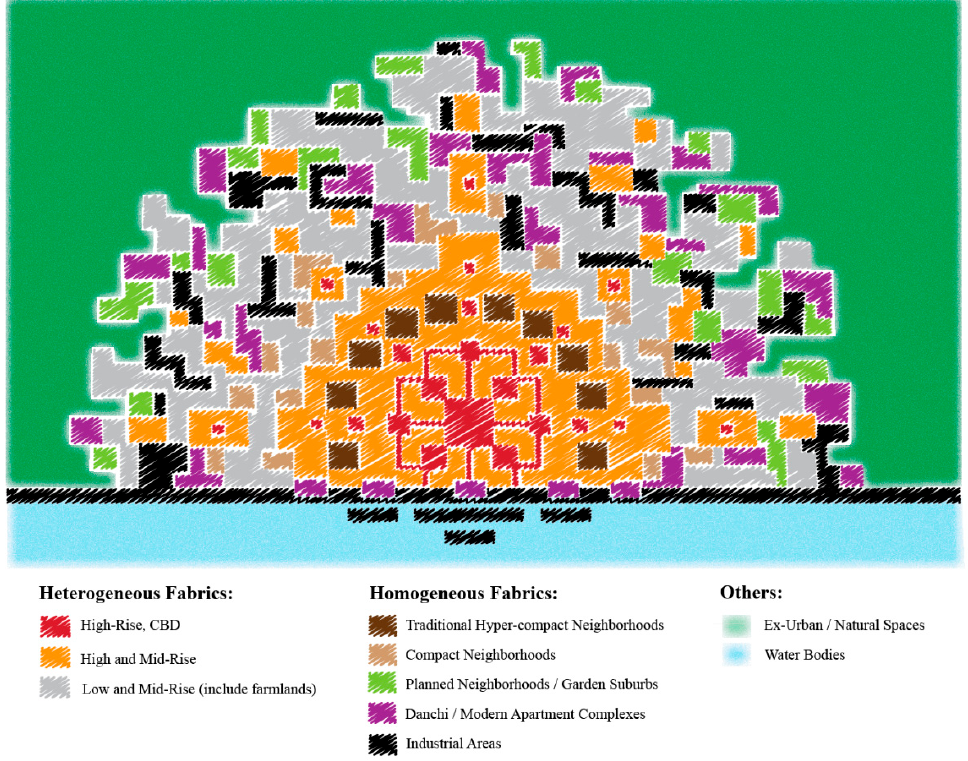
Figure 7. A model of the Japanese metropolitan city, based upon Osaka.